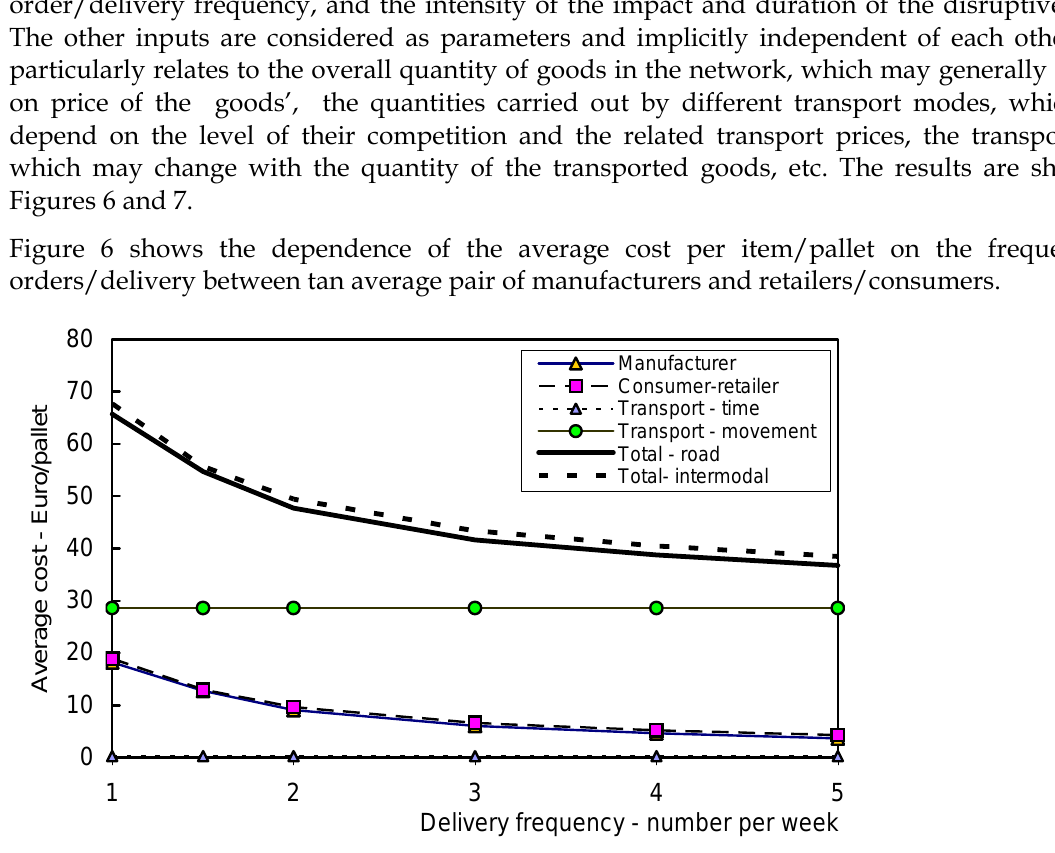
Figure 6. Dependence of the average cost per pallet on the order/delivery frequencies in a given